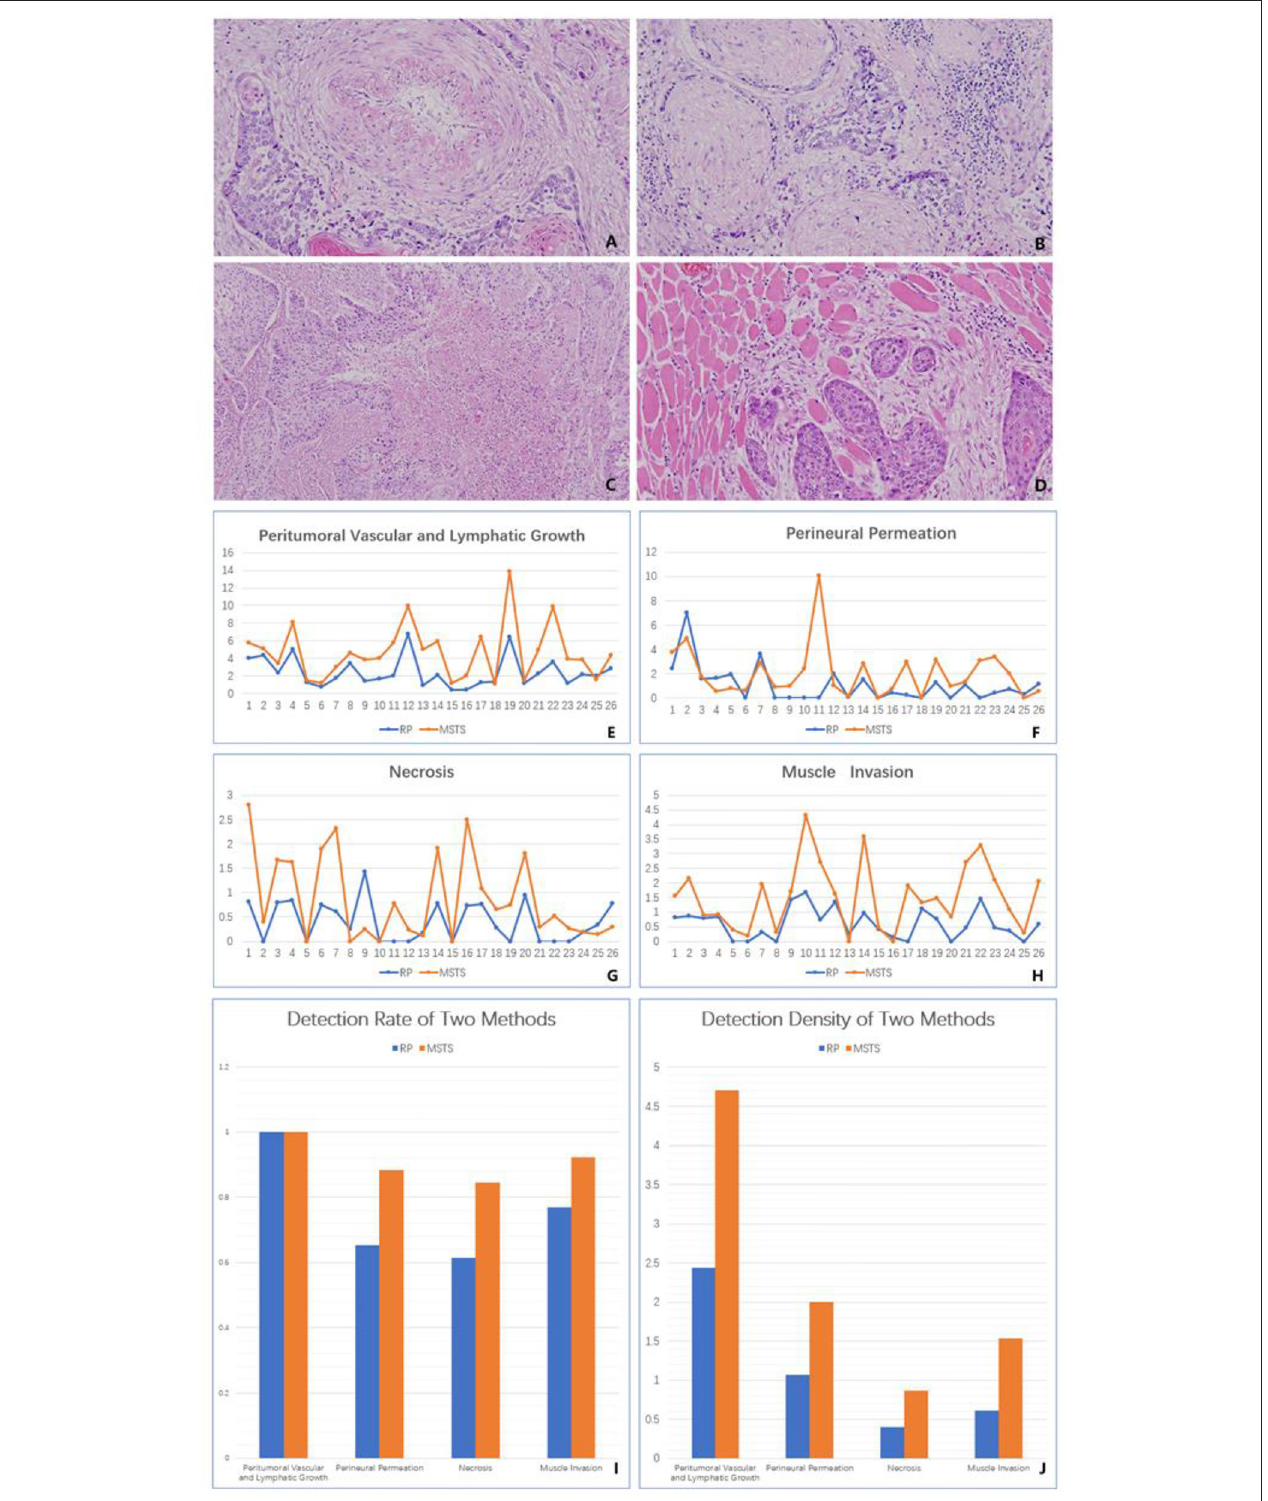
FIGURE 3 | Histology. (A) Peritumoral vascular and lymphatic growth (original magnification was 40 × ). (B) Perineural permeation (original magnification was 40 × ). (C) Tumour necrosis (original magnification was 40 × ). (D) Muscle invasion (original magnification was 40 × ). (E) The detection density of peritumoral vascular and lymphatic growth in two methods. (F) The detection density of perineural permeation in two methods. (G) The detection density of tumour necrosis in two methods. (H) The detection density of muscle invasion in two methods. (I) The detection rate of two methods in the four histological parameters. (J) The detection density of two methods in the four histological